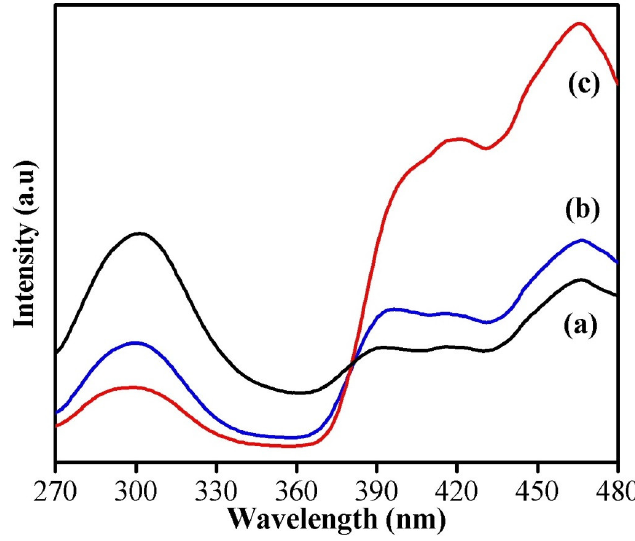
Figure 5. PL spectra of ( a ) phthalic-acid-, ( b ) citric-acid-, and ( c ) oxalic-acid-assisted WO 3 nanoparticles.